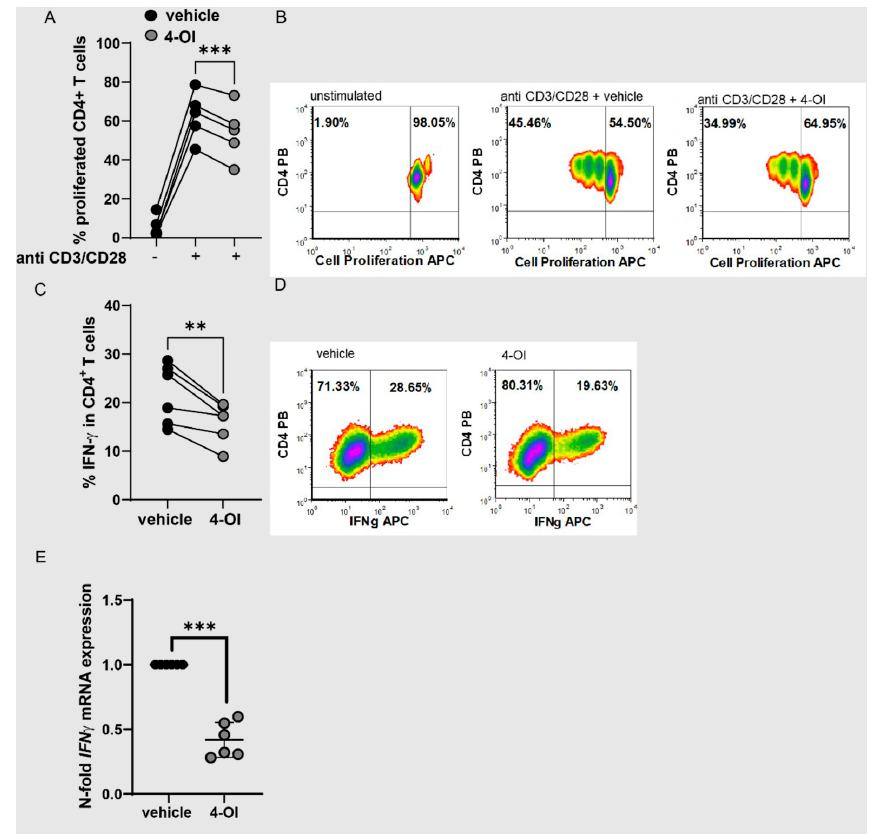
Figure 5. 4-OI reduces proliferation and IFN- γ production of CD4 + T cells. ( A , B ) CD4 + T cells